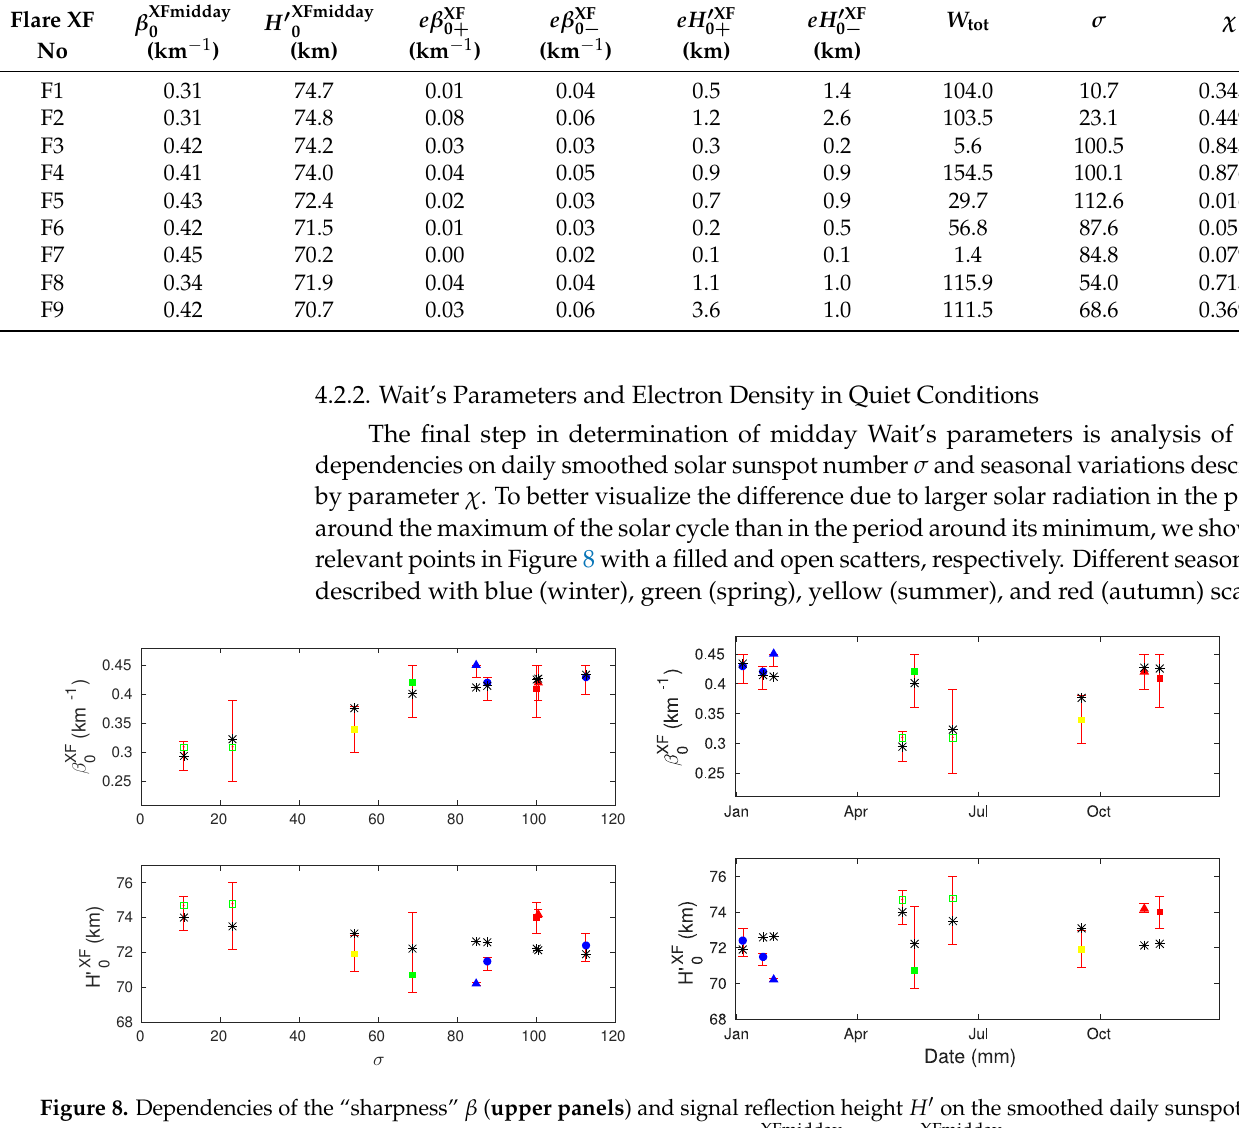
and H (cid:48) XFmidday are shown as filled (for 0 0